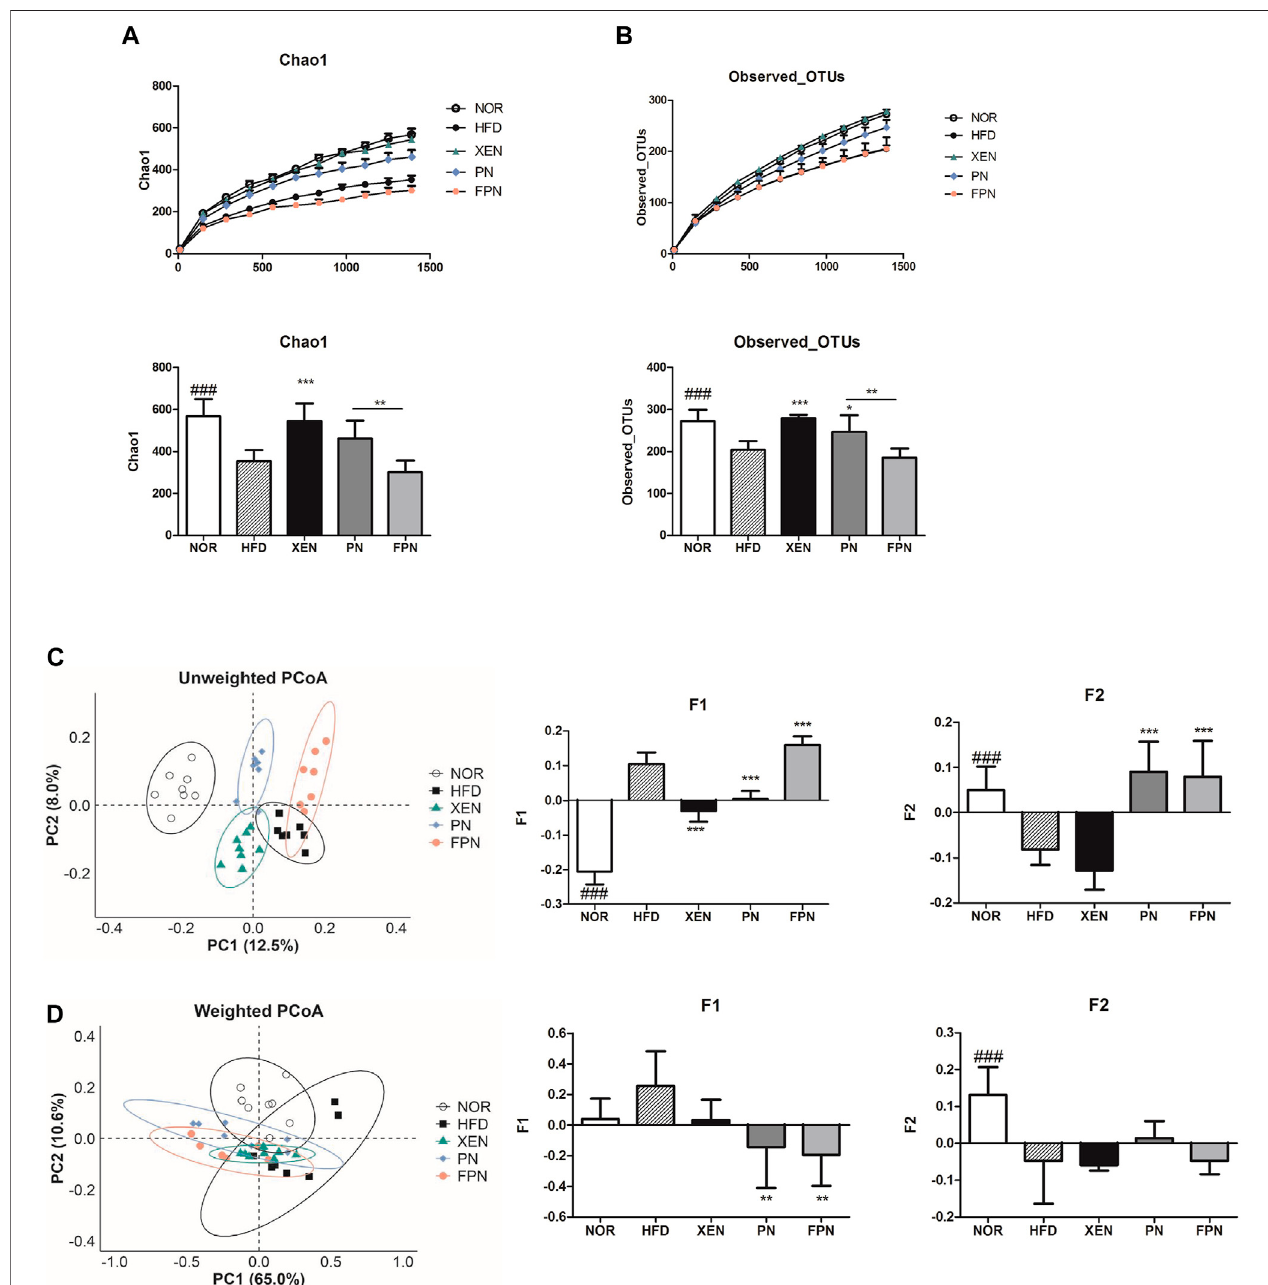
FIGURE 7 | Changes in the diversity and structure of the gut microbiota in response to exposure to PN or FPN in the HFD-induced mouse model. The alpha diversity was measured from (A) Chao 1 and (B) observed OTUs. PCoA score plot calculated from OTU level by QIIME was subjected to (C) unweighted and (D) weightedUniFracanalysis. The dataare expressed asthemean ± SEM ( n (cid:2) 7 – 8); ### p < 0.001; NOR vs. HFD group. * p < 0.05; ** p < 0.01; *** p < 0.001;HFD group vs. treatment groups (XEN, PN and FPN).